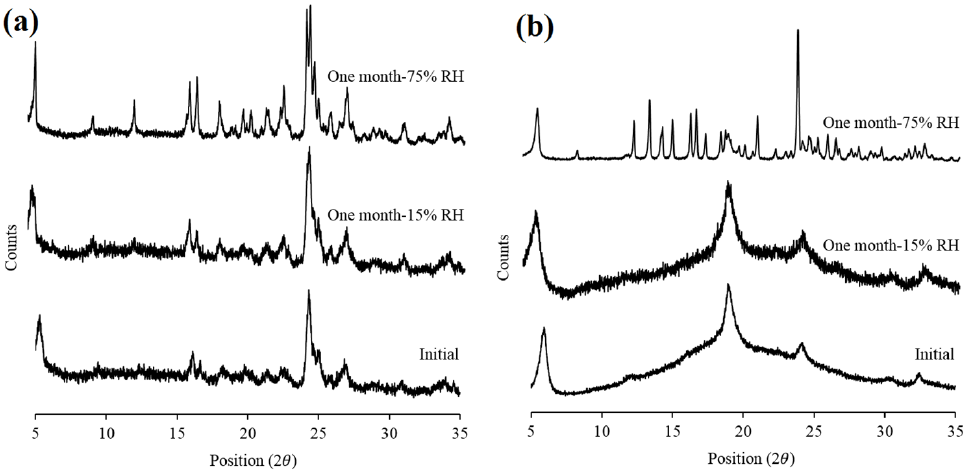
Figure 6. X-ray diffractograms of the spray-dried roflumilast-only ( a ) and cospray-dried ( b ) powders after one month storage at different storage conditions (for ease of comparison, the initial data from Figure 2 are shown here.). Table 6. In vitro aerosolization of spray ‐ dried and cospray ‐ dried roflumilast powders after one month of storage at 15% and 75% RH and 25 °C. SD and CoSD mean spray ‐ dried and cospray ‐ dried, respectively; ED: emitted dose; FPF: fine particle fraction; data are means ± standard deviations, n = 3; initial data from Table V are used for comparison. * The value is significantly different ( p < 0.05) to the value on day 0 (initial).